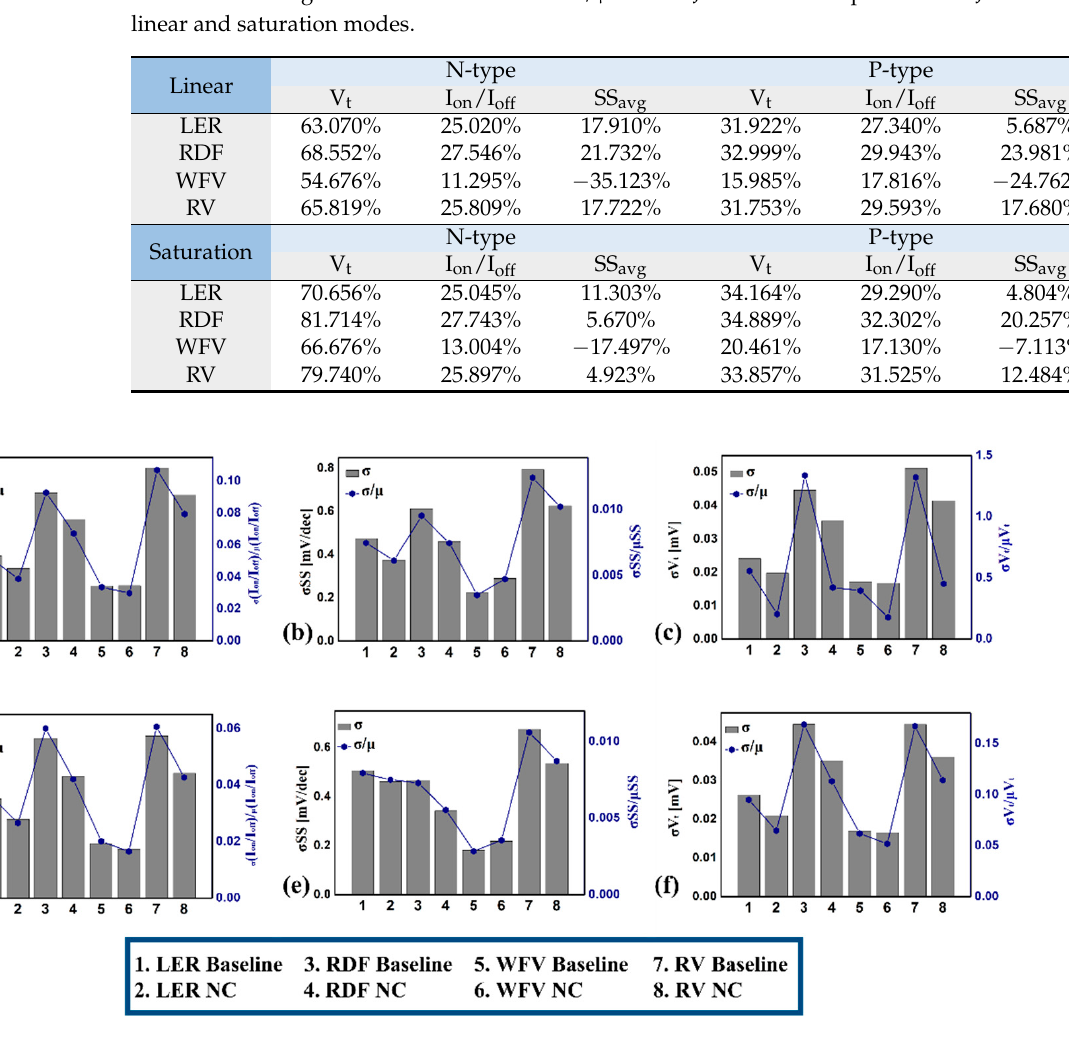
Figure 7. ( a ) On/off ratio variation [ σ (I on /I off )] and [ σ (I on /I off )/µ(I on /I off )] comparison, ( b ) SS variation [ σ (SS)] and [ σ (SS)/µ(SS)] comparison and ( c ) V t variation [ σ (V t )] and [ σ (V t )] comparison between n-type JL-NWFET and n-type NC-JL-NWFET in linear mode. ( d ) On/off ratio variation [ σ (I on /I off )] and [ σ (I on /I off )/µ(I on /I off )] comparison, ( e ) SS variation [ σ (SS)] and [ σ (SS)/ µ (SS)] comparison and ( f ) V t variation [ σ (V t )] and [ σ (V t )] comparison between p-type JL-NWFET and p-type NC-JL-NWFET in linear